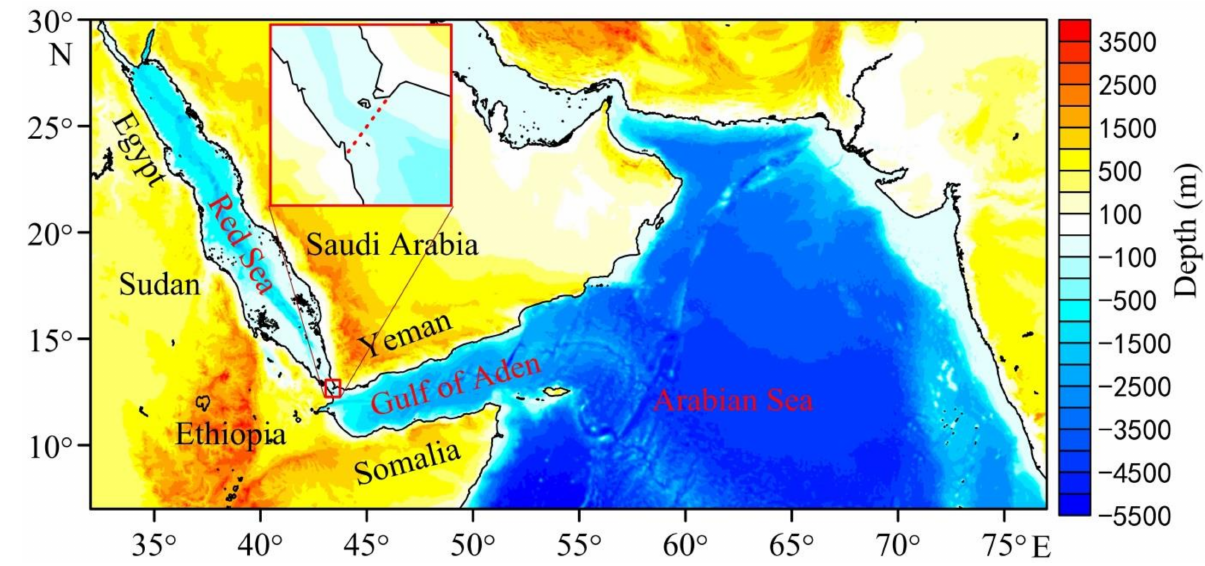
Figure 1. Map and topography (using GEBCO_2014 data) of the study area and the connection of Red Sea with Gulf of Aden through Bab-el-Mandab Strait. Dashed line at the strait was used to calculate the horizontal heat flux across